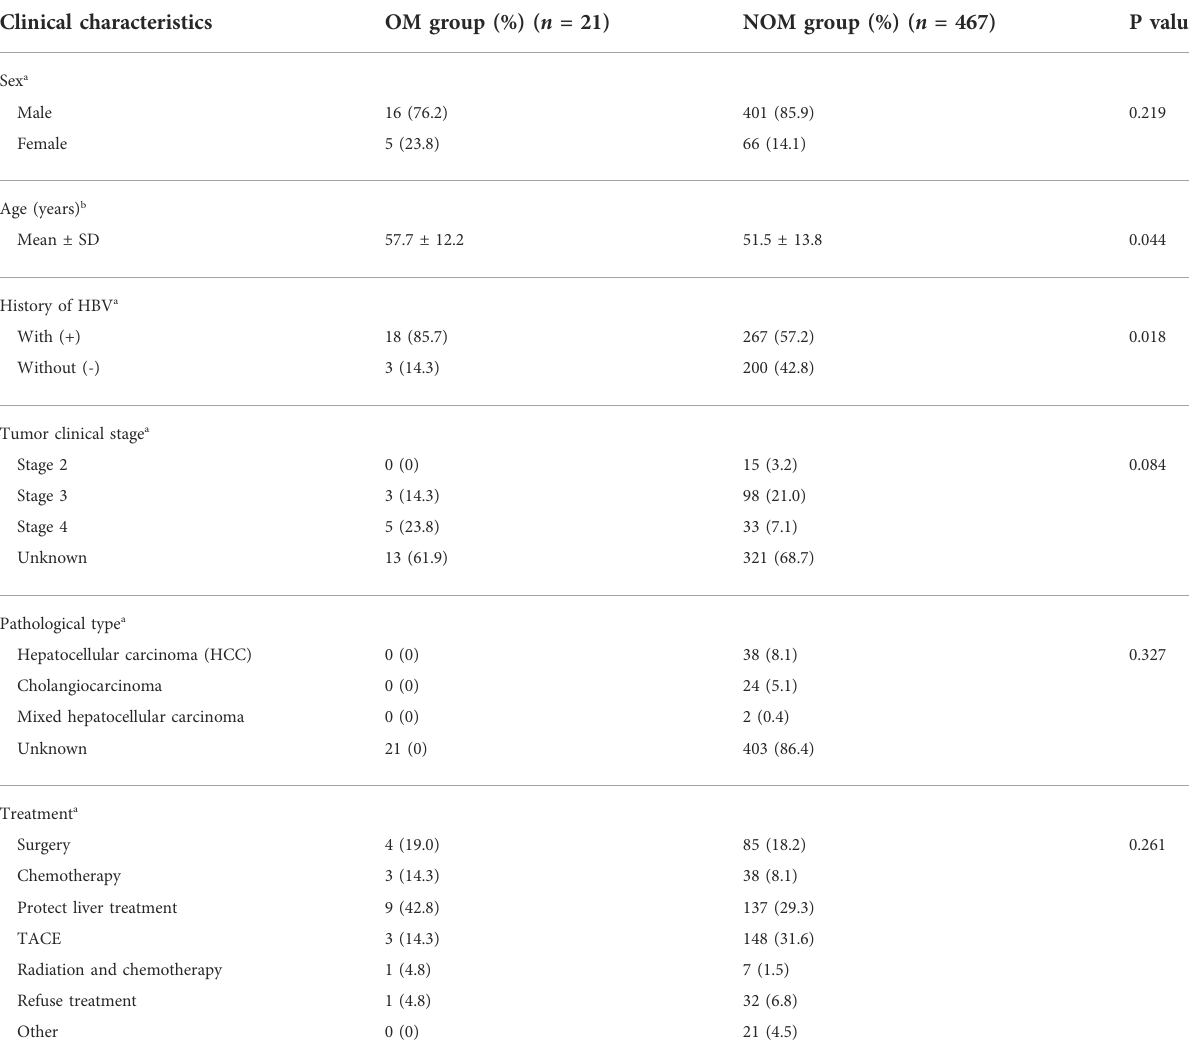
TABLE 1 The clinical characteristics of patients with metastases of primary liver cancer. Clinical